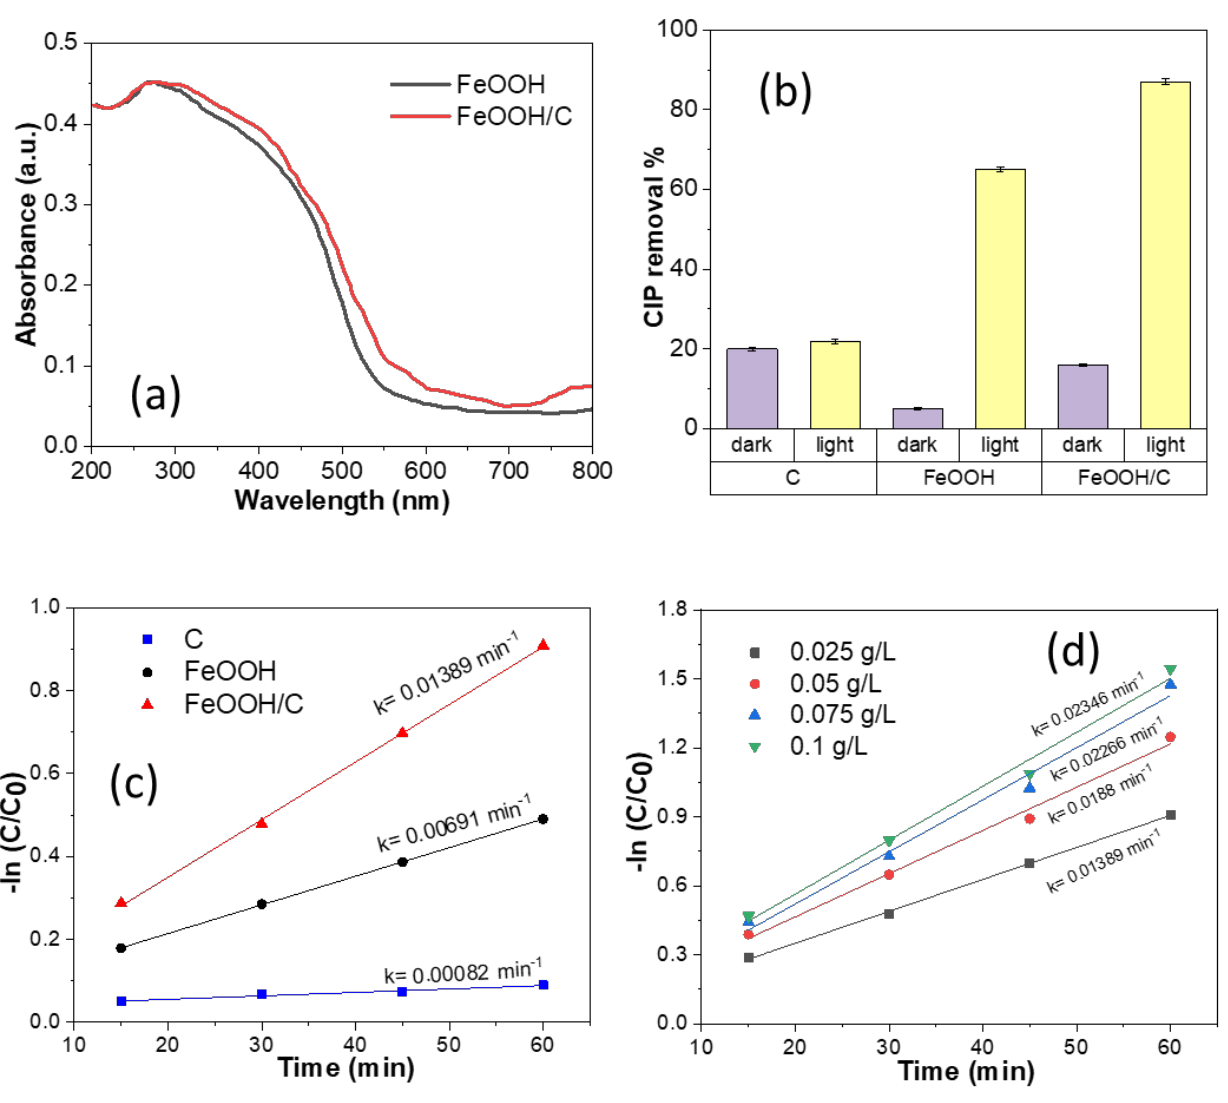
Figure 4. ( a ) UV-vis absorption spectra of carbon derived from Indian blackberry seeds, α − FeOOH and the FeOOH/C composite, ( b ) the extent of ciprofloxacin (CIP) by carbon, α − FeOOH and the FeOOH/C composite, ( c ) the plot of − ln ([ C ]/[ C 0 ]) vs. t and ( d ) the effect of concentration of the FeOOH/C composite on the photodegradation of CIP.